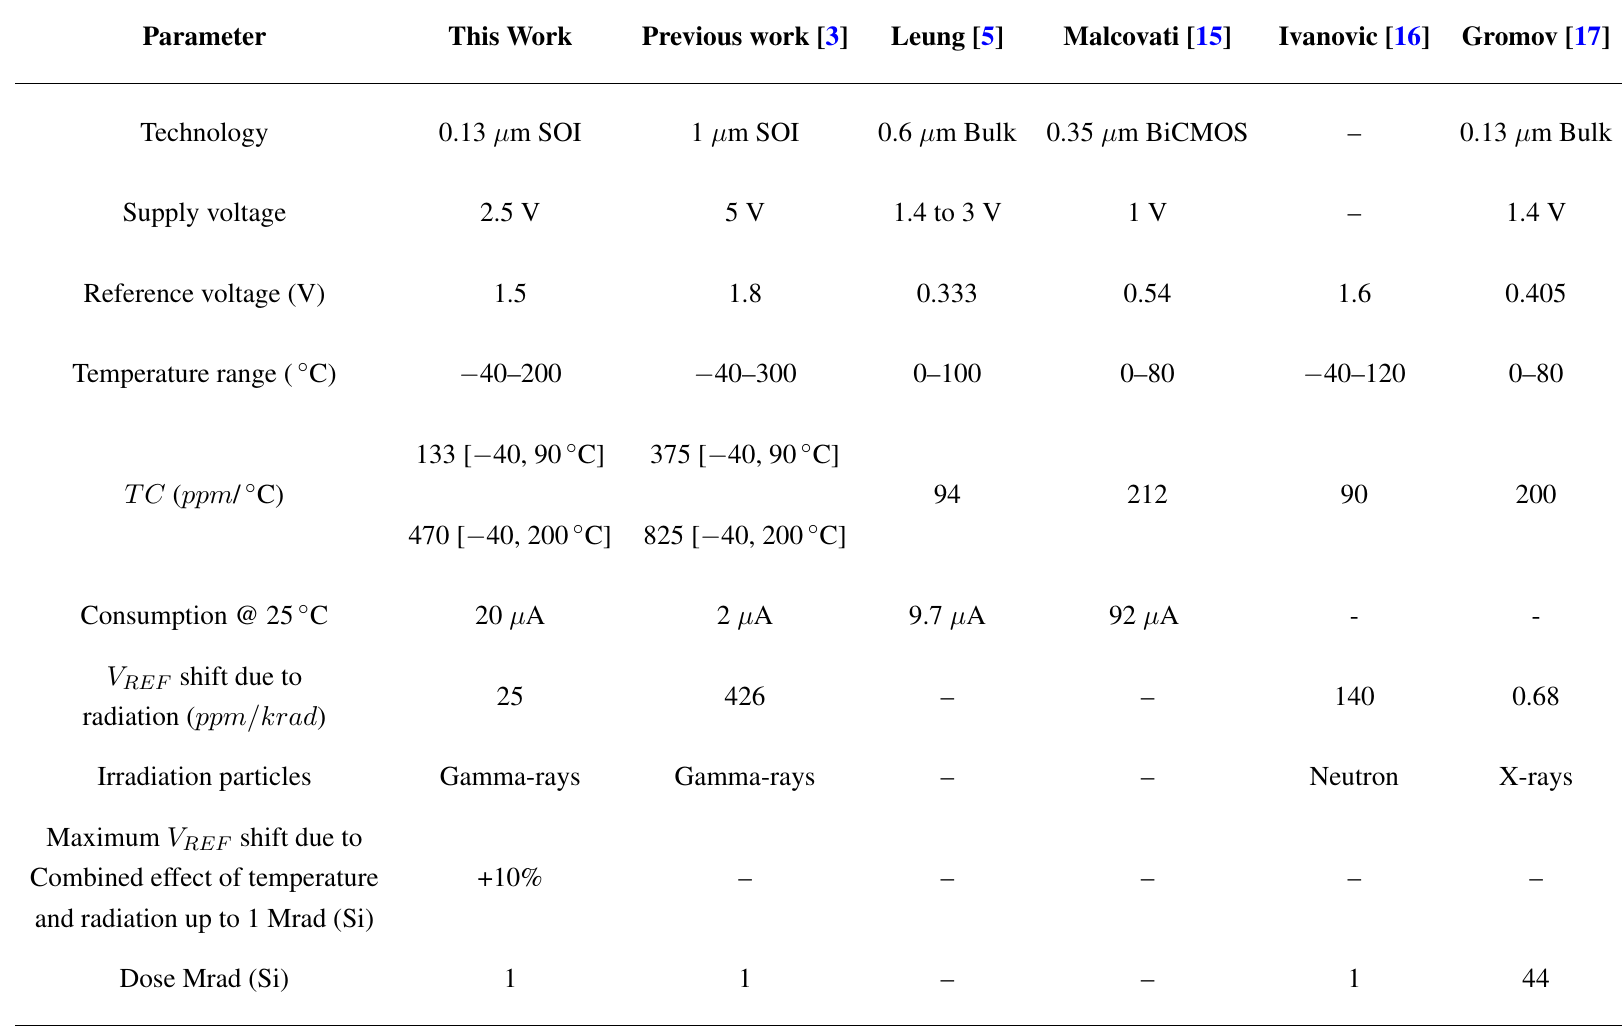
Table 2. Performance comparison with similar voltage references described in the